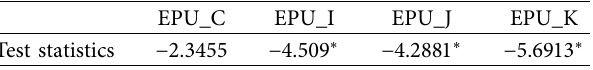
Table 4: KSS unit root test